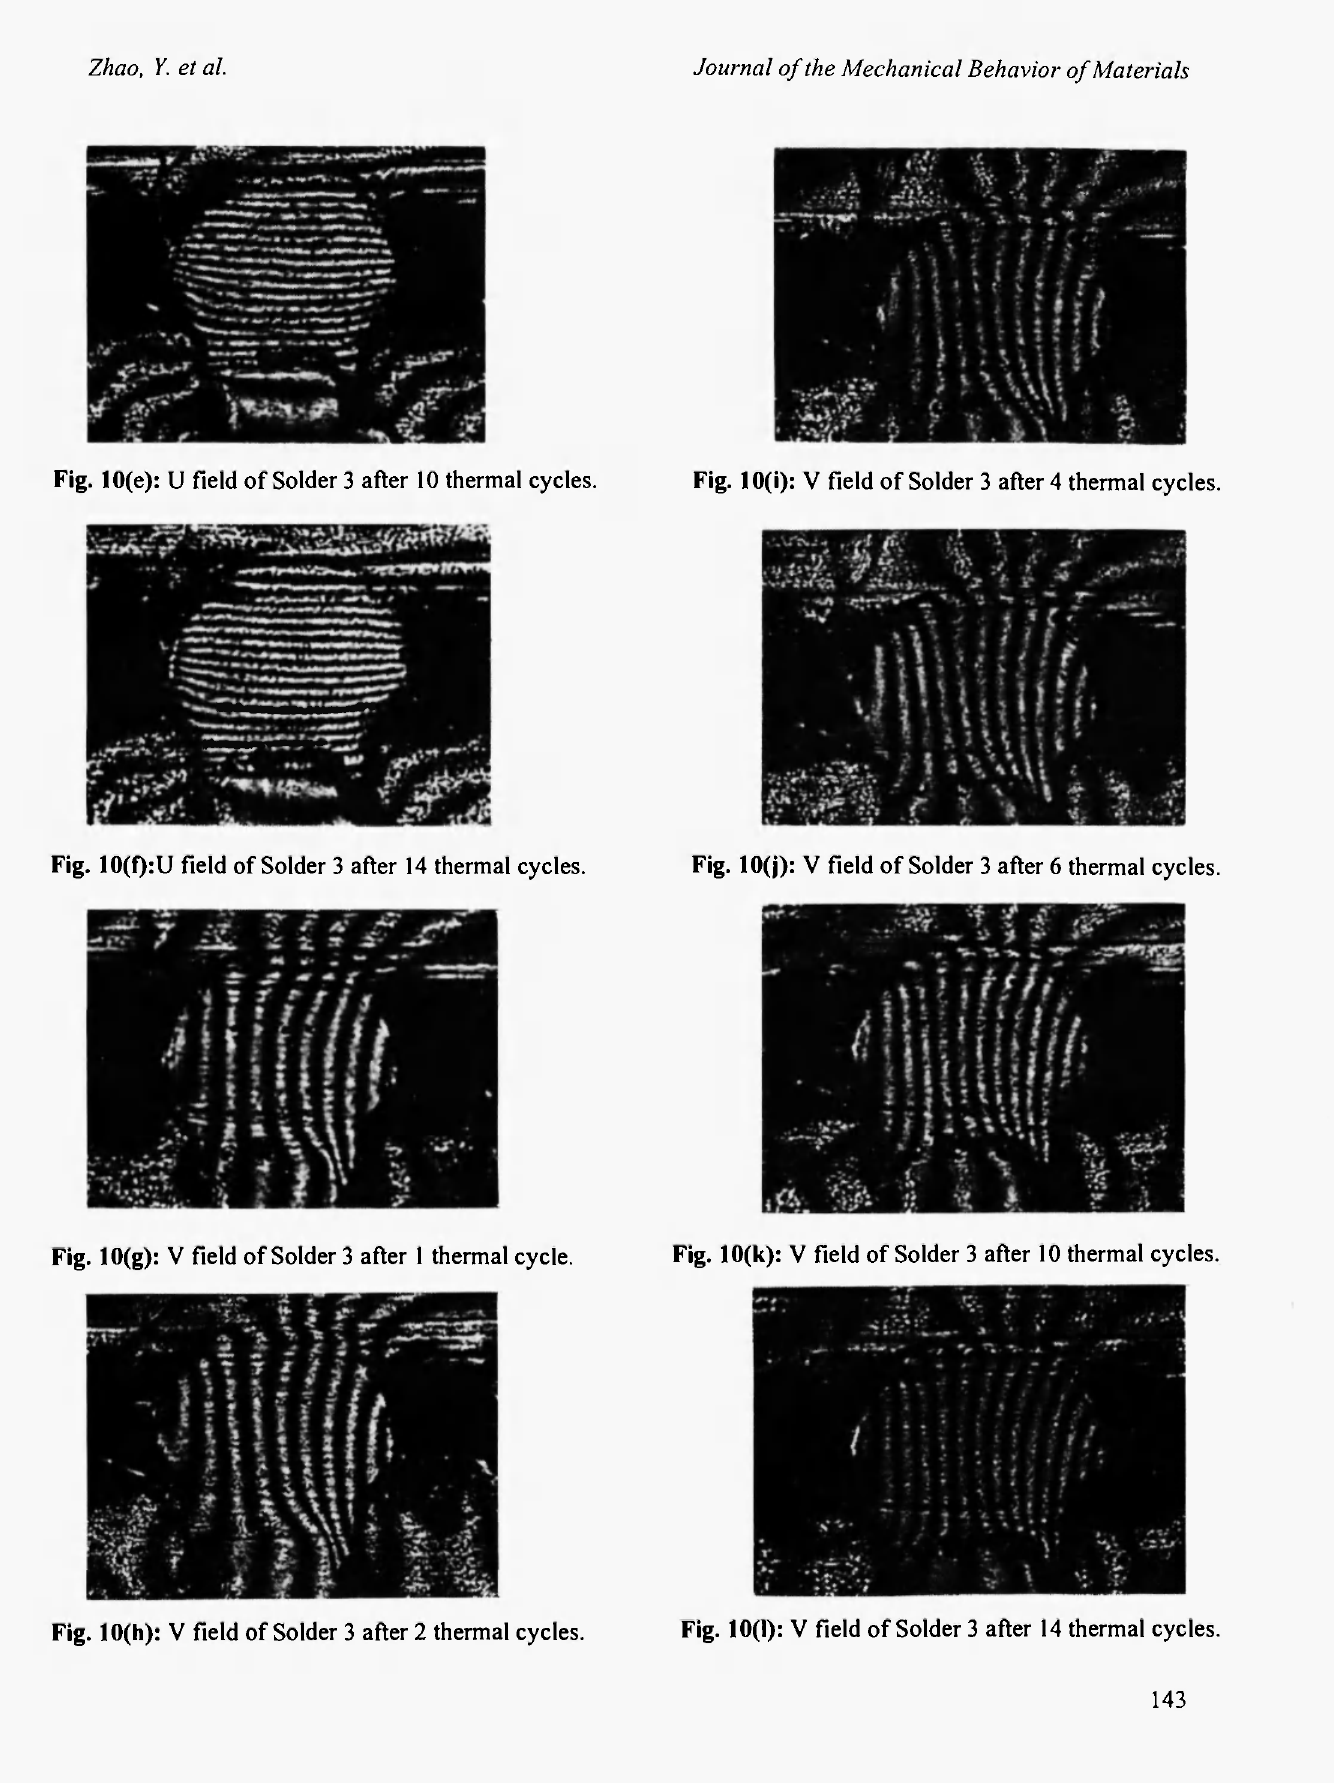
Fig. 10(h): V field of Solder 3 after 2 thermal cycles.